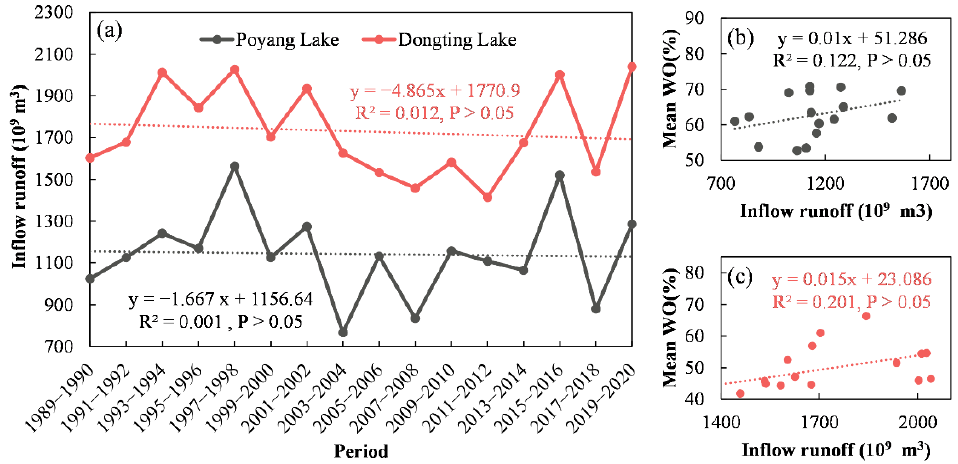
Figure 12. Inflow runoff changes in Poyang Lake and Dongting Lake. ( a ) indicates the time series of inflow runoff in Poyang Lake and Dongting Lake. ( b ) indicate the relationship between inflow runoff and mean WO in Poyang Lake. ( c ) indicate the relationship between inflow runoff and mean WO in Dongting Lake.